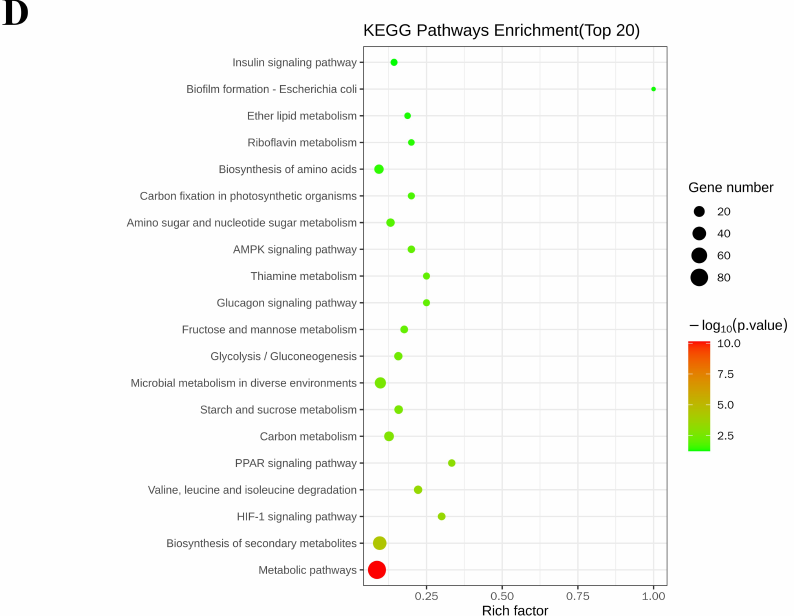
Figure 5. Transcriptobomics profile of P. italicum treated with 2 − CDs. ( A ) Volcano plot of DEGs (|Log2 FC| > 1 and p -value < 0.05) between D − 2 − CDs and D − C. ( B ) Hierarchical cluster analysis of total DEGs (i: D − C, i2: D − 2 − CDs). ( C ) The top 30 enrichments of GO terms of DEGs. BP: biological processes; MF: molecular function; CC: cellular components. ( D ) Top 20 KEGG pathways of the identified DEGs. Red color: low p -value; green color: high p -value; circle size corresponds to gene number.